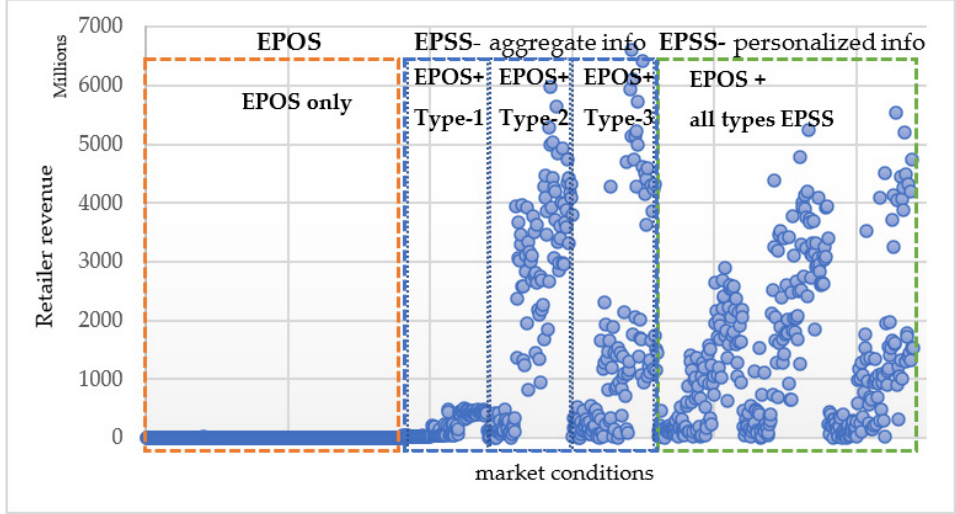
Figure 5. Market condition effect on retailer